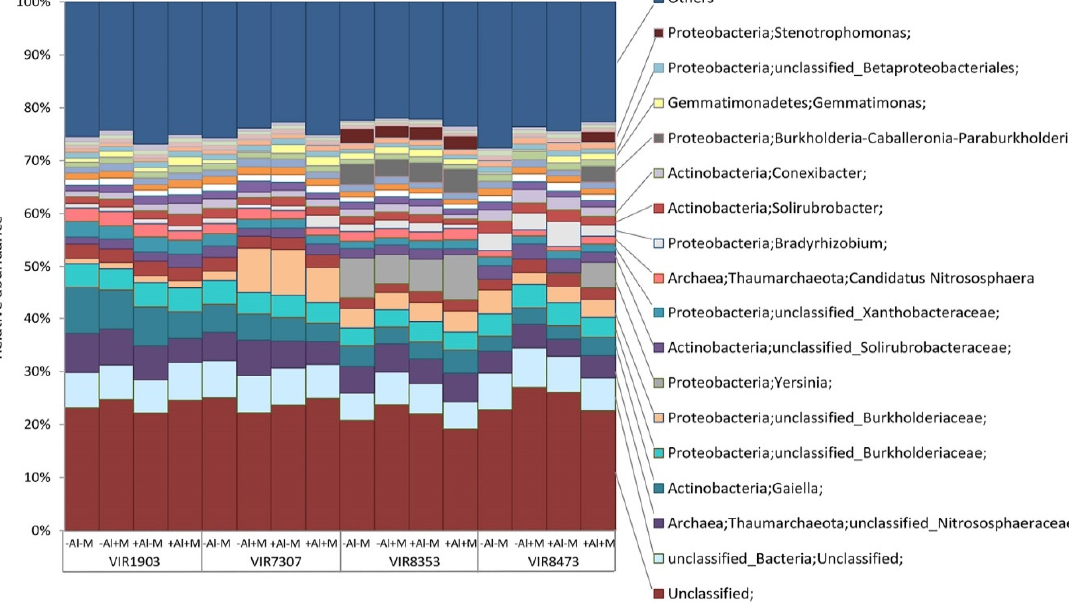
Figure 8. Procaryotic microbiome taxonomic structure at the genus level of the rhizosphere of pea genotypes VIR1903, VIR7307, VIR8353 and VIR8473 inoculated with microbial consortium. Others